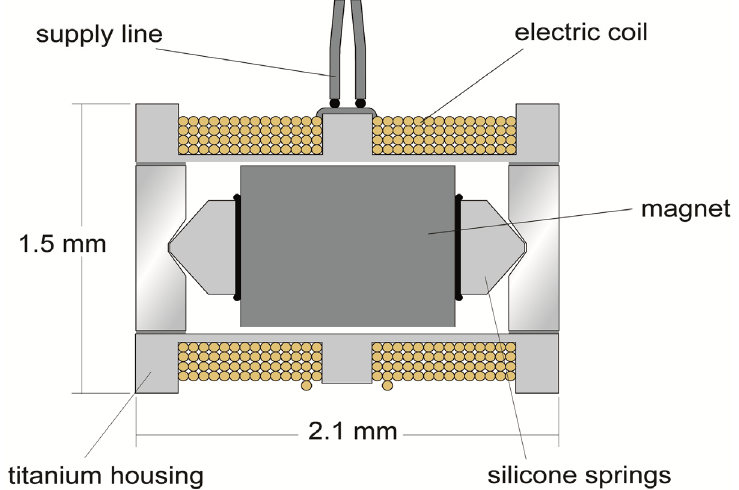
Figure 7. Cross-section of the floating mass transducer (Reprinted from